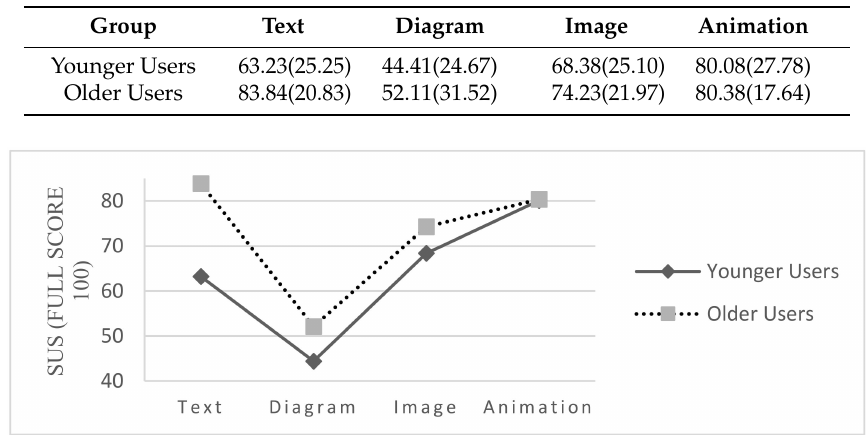
Figure 13. Comparison of the SUS results of the younger and older